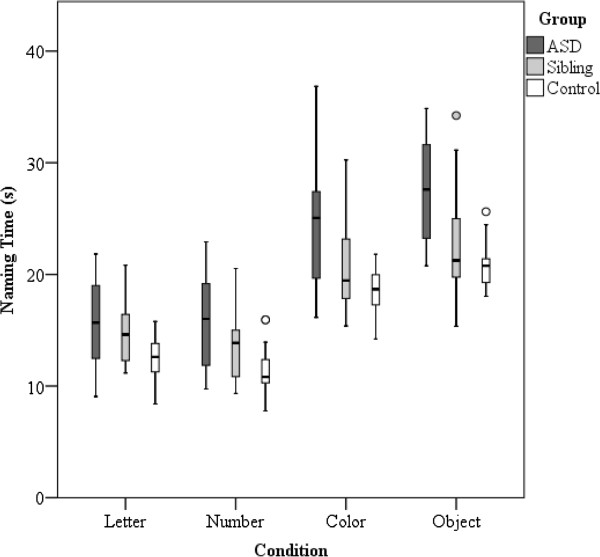
Box plot displaying distribution of naming time (seconds) across groups for the four RAN conditions. The interquartile range (IQR), between the 25th and 75th percentile, is indicated by the lower and upper boundaries of each box, respectively. The horizontal line indicates the median value. Outliers (values 1.5–3 IQRs from the end of the box) are denoted by a circle.